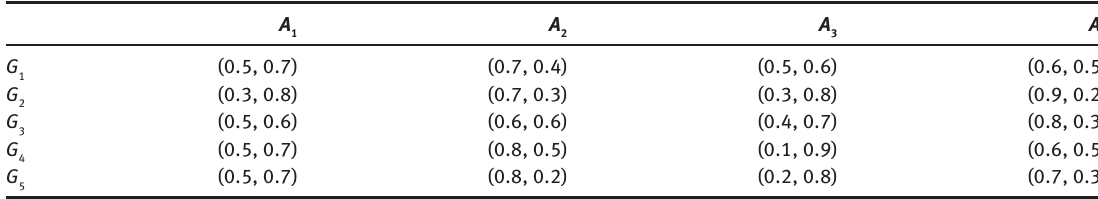
Table 7: Normalized Decision Matrix R 3